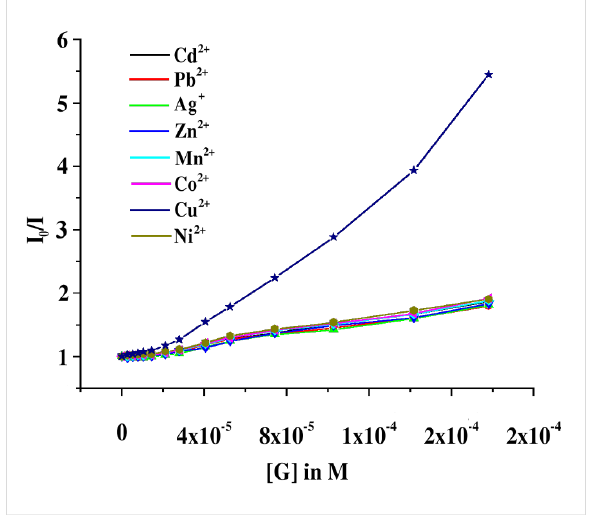
Figure 6: Stern–Volmer plot of receptor 2 ( c = 1.48 × 10 − 5 M) at 413 nm upon addition of 20 equiv of a particular guest in CH 3 CN containing 0.02% DMSO ( λ ex = 348